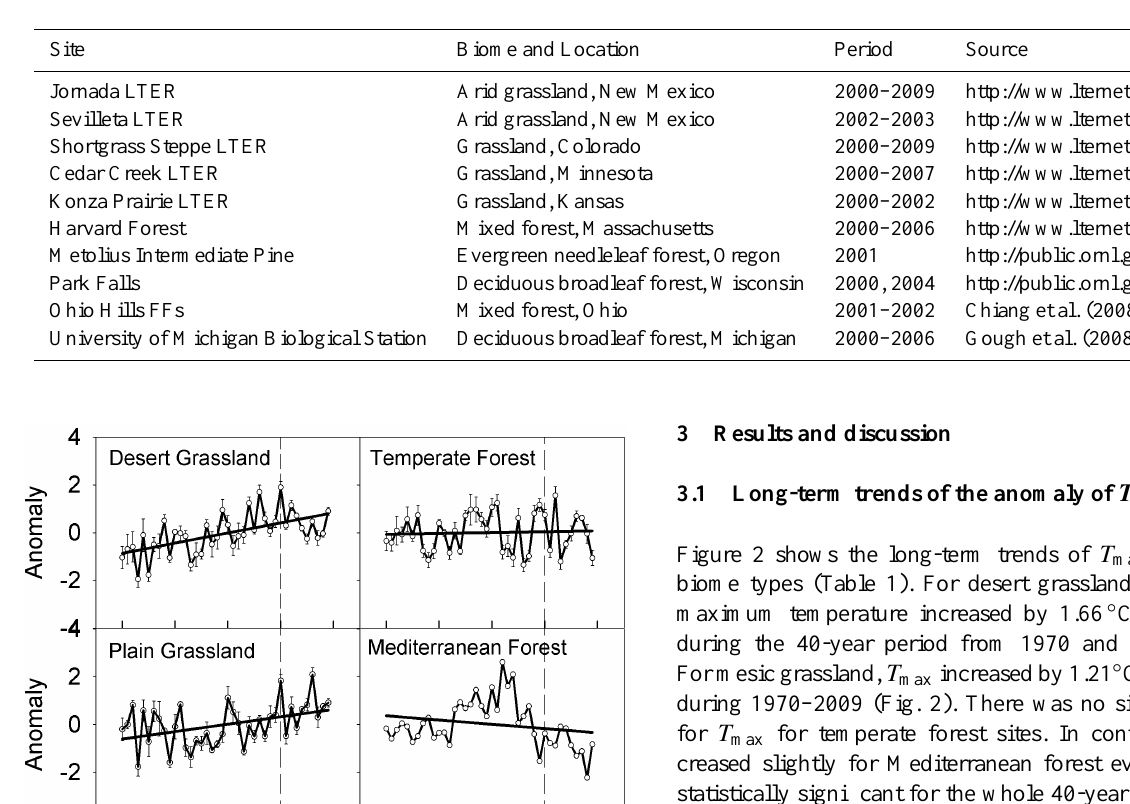
Table 2. Sites with “in-situ” ANPP measurements within the period of 2000–2009 for validation with iEVI.